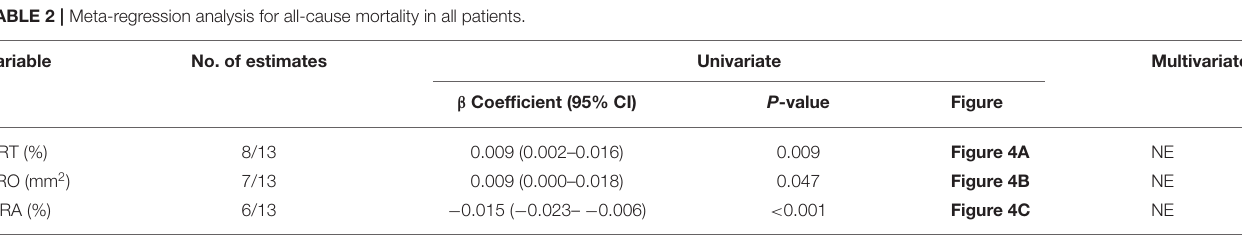
TABLE 2 | Meta-regression analysis for all-cause mortality in all patients.